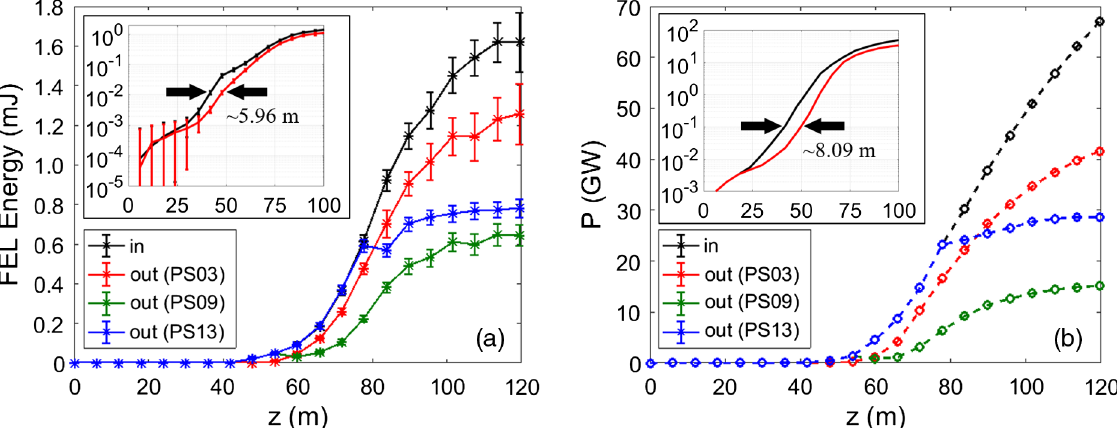
FIG. 5. (a) Measured FEL gain curve from experiment (bars, (cid:4) 1 s : d : ; n ¼ 100 ) and (b) averaged radiation power from simulation along the undulator line for four cases: in phase (black) and out of phase of the phase shifter at 18 (red), 54 (green), and 78 m (blue). Inset: Log scale of two cases (the in-phase and the out-of-phase PS03).